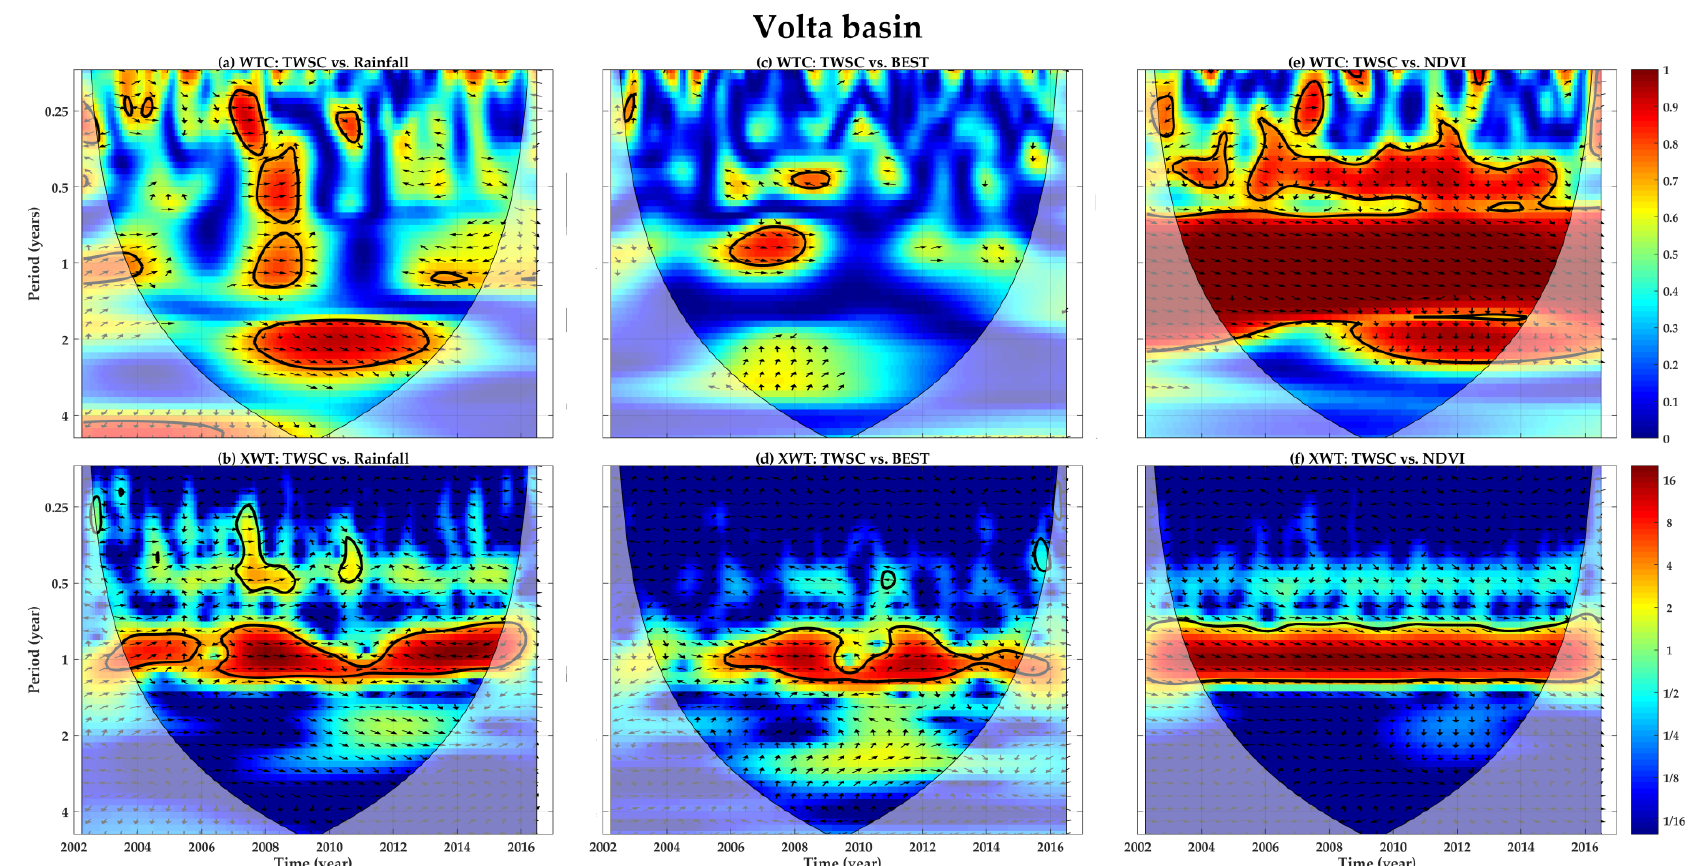
Figure 10. Wavelet coherency (WTC) and the corresponding cross-wavelet coherency (XWT) showing the interactions between the regional TWSC of the Volta Basin and the TRMM rainfall ( a , b ), the Bivariate ENSO Time Series (BEST) ( c , d ), and the normalized difference vegetation index (NDVI) ( e , f ). Black contour lines indicate the 95% confidence level against the red noise between the variables, while the shaded cone represents the cone of influence (COI). The relative phase relationships are denoted by arrows designating the phase difference between two variables A and B. The phase arrows pointing right ( → ) depict the in-phase, those pointing left ( ← ) depict the anti-phase, those pointing down ( ↓ ) indicate that A is leading B by 90°, and those pointing up ( ↑ ) indicate that B is leading by 90°.